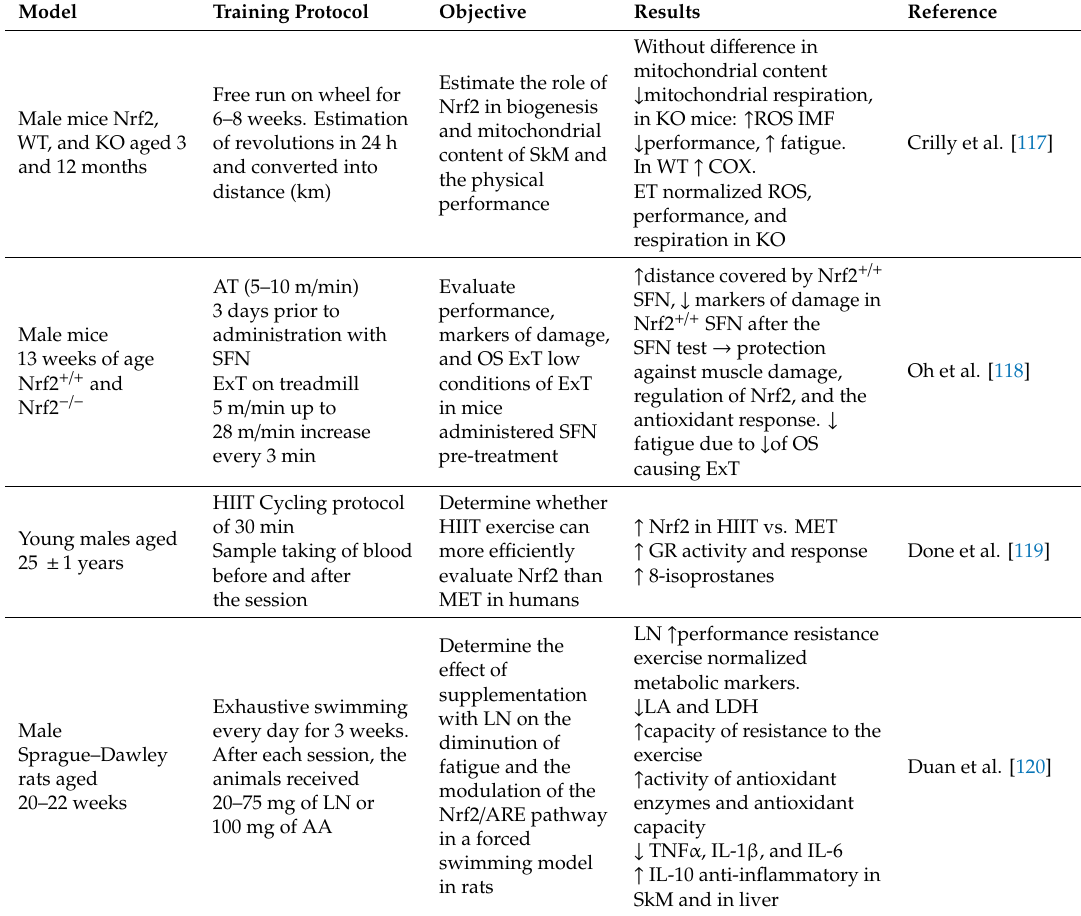
Table 2. Studies that have demonstrated the induction of Nrf2 and the antioxidant cytoprotector system due to the e ff ect of physical exercise and bioactive